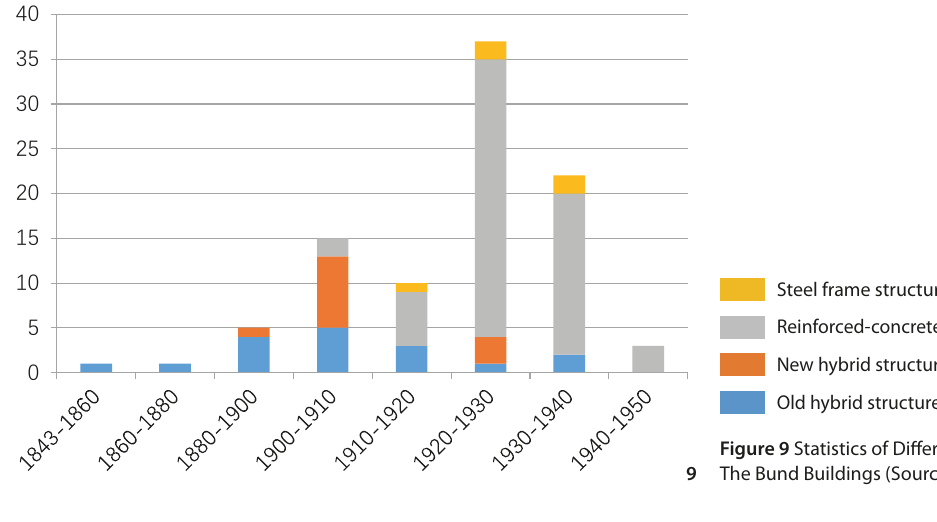
Figure 9 Statistics of Different Building Structures Used in The Bund Buildings (Source: the author).